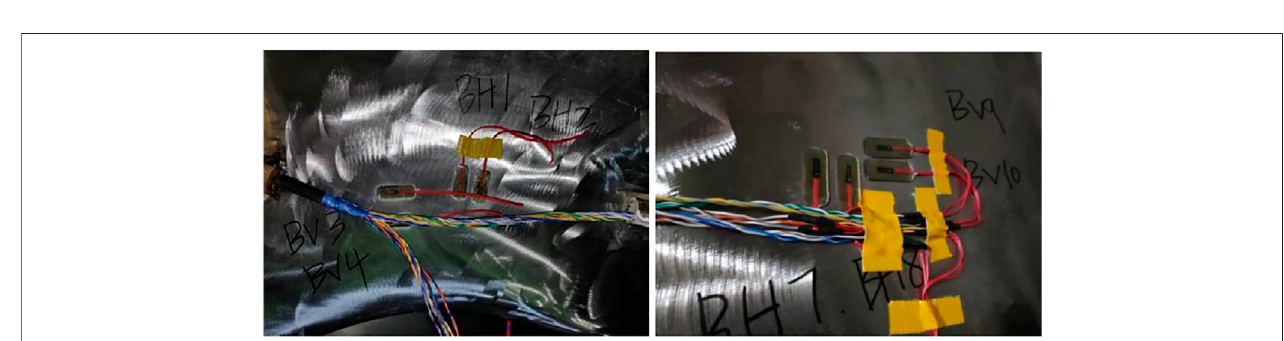
FIGURE 5 | The photos of fi xing the strain gauges by special glue.